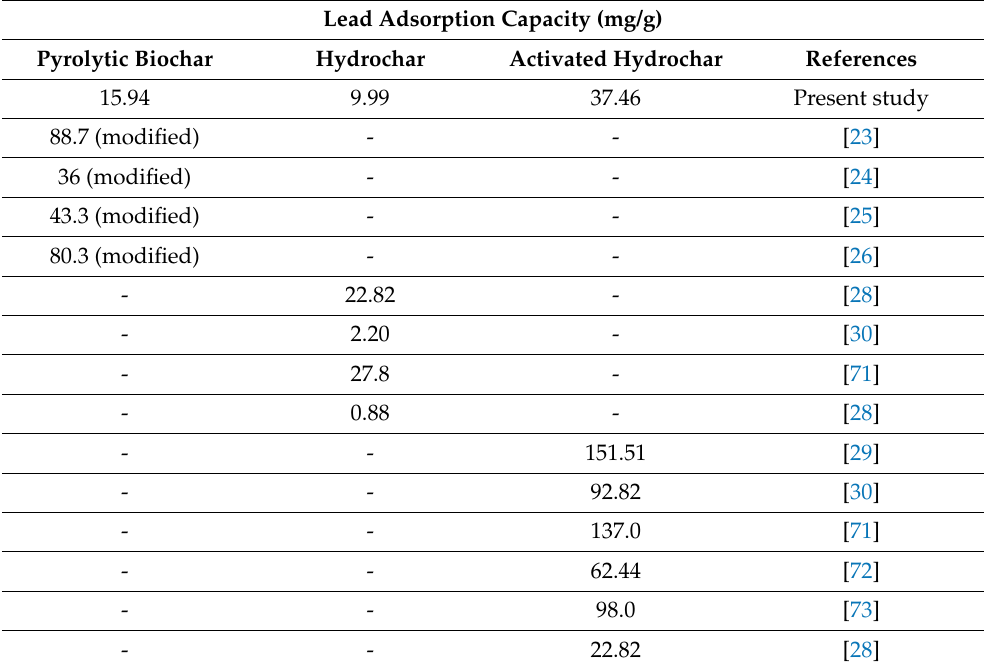
Table 5. The lead adsorption capacity for PBc, Hc, and AcHc was obtained from various feedstocks. Lead Adsorption Capacity